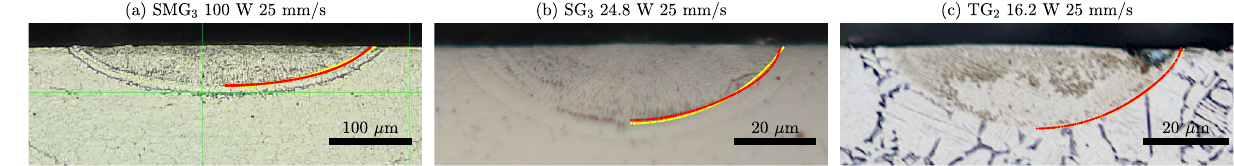
Figure 2. Comparison of experimental and computational 2D melt pool traces for 3 of the 11 cases in Table 1. Results of the convective model are shown in red, while those of the conductive model are in yellow. The optimal values for α and z S were used to obtain the computational 2D melt pool traces in each case, and are reported in Table 1. Only half of the computed trace is shown so that the experimental one is not